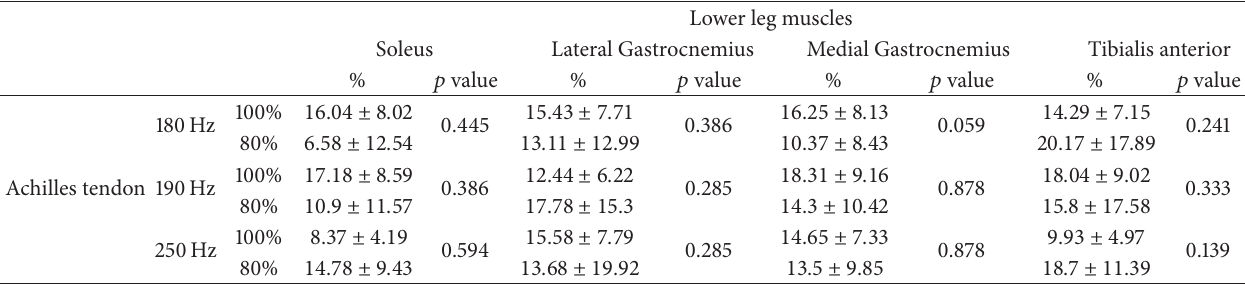
Table 2: The increase rate of muscle force according to the intensity of vibration, perception threshold (100%) and subthreshold (80%) on the Achilles tendon [%].